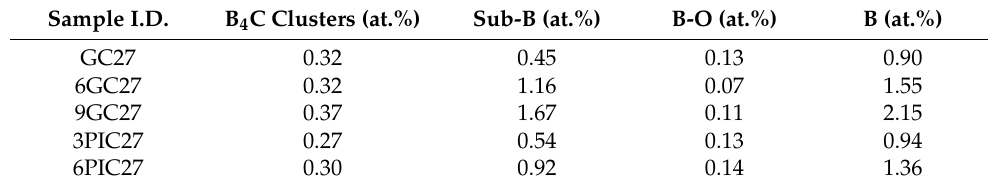
Figure 1. B1s XPS spectra of the boron-doped graphite studied. ( a ) Boron-doped graphite pre- pared using needle coke (GC) as raw material; ( b ) Boron-doped graphite prepared using pitch coke (PIC) as raw material.